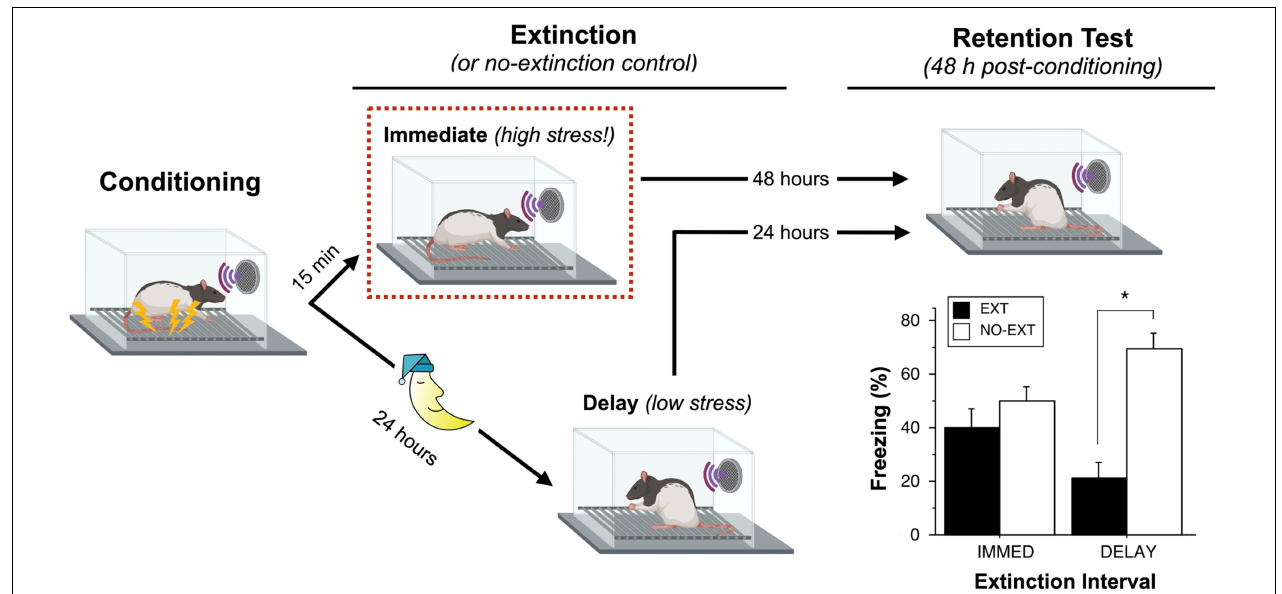
FIGURE 1 | Recent fear is resistant to extinction. Maren and Chang (2006) compared groups of rats that underwent an extinction (EXT) procedure either 15 min or 24 h after auditory fear conditioning; each of these groups was compared to a group of animals that did not undergo extinction (NO-EXT). During the extinction session, rats in the IMMED condition exhibit high levels of sensitized fear (high stress) prior to the first extinction trial, whereas rats in the DELAY condition exhibit low levels of freezing (low stress). Despite showing similar levels of within-session extinction, rats in the IMMED condition exhibit poor long-term retention of extinction relative to animals in the DELAY condition. Unlike DELAY rats, rats in the IMMED condition exhibited similar and high levels of conditioned freezing compared to non-extinguished controls. Elements of the figure were created with BioRender.com; the data shown in the plot were previously published (Maren and Chang, 2006).